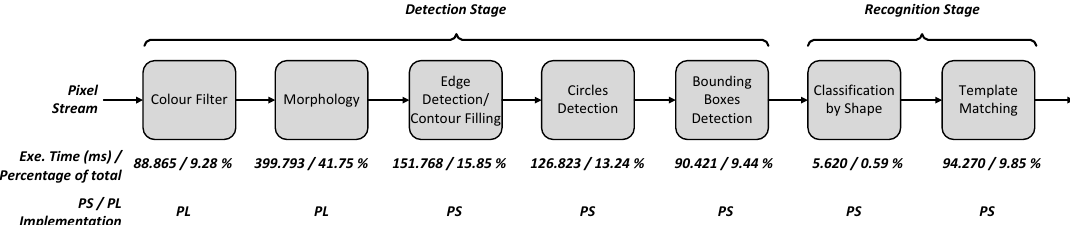
Figure 12. Section execution times and ratios for each stage of the traffic sign recognition